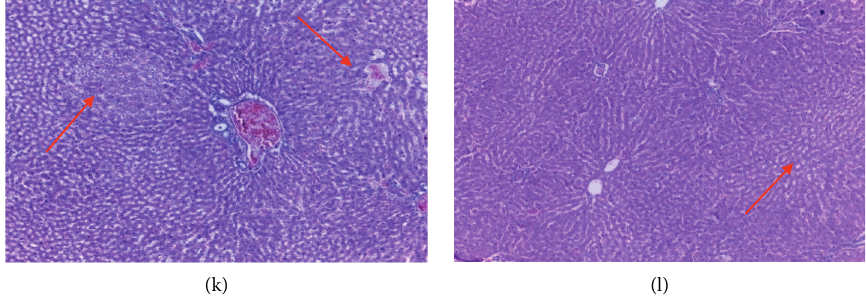
Figure 2: Microscopic pictures of the liver sections from different groups. Note. (a) Normal control group: rats treated with 2% Tween-80 followed by NS, (b) negative control group: rats received APAP alone, (c) rats received 100 mg/kg CAME, (d) rats received 200 mg/kg CAME, (e) rats received 400 mg/kg CAME, (f) rats received 100 mg/kg CAAE, (g) rats received 200 mg/kg CAAE, (h) rats received 400 mg/kg CAAE, (i) rats received 400 mg/kg CAAF, (j) rats received 400 mg/kg CABF, (k) rats received 400 mg/kg CACF, and (l) positive control group: rats received 100 mg/kg silymarin. Black arrows indicate areas of tissue necrosis and red arrows indicate areas of vacuolar degeneration of varying degree. APAP: acetaminophen, CAAE: aqueous extract of Cordia africana, CAAF: aqueous fraction of Cordia africana, CABF: butanol fraction of Cordia africana, CACF: chloroform fraction of Cordia africana, CAME: 80% methanol extract of Cordia africana, mg/kg: milligram per kilogram, and NS: normal saline.